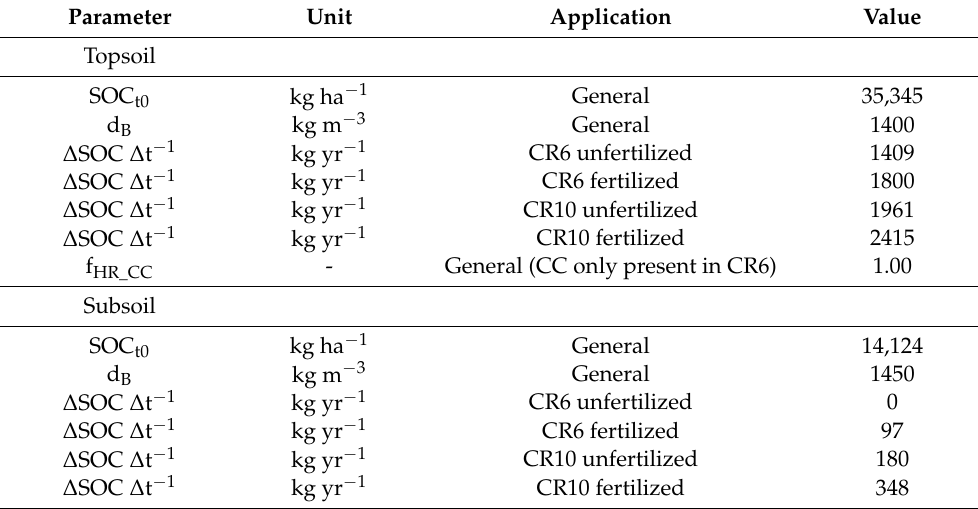
Table A2. Topsoil- and subsoil-specific parameters with constant values used in the model.